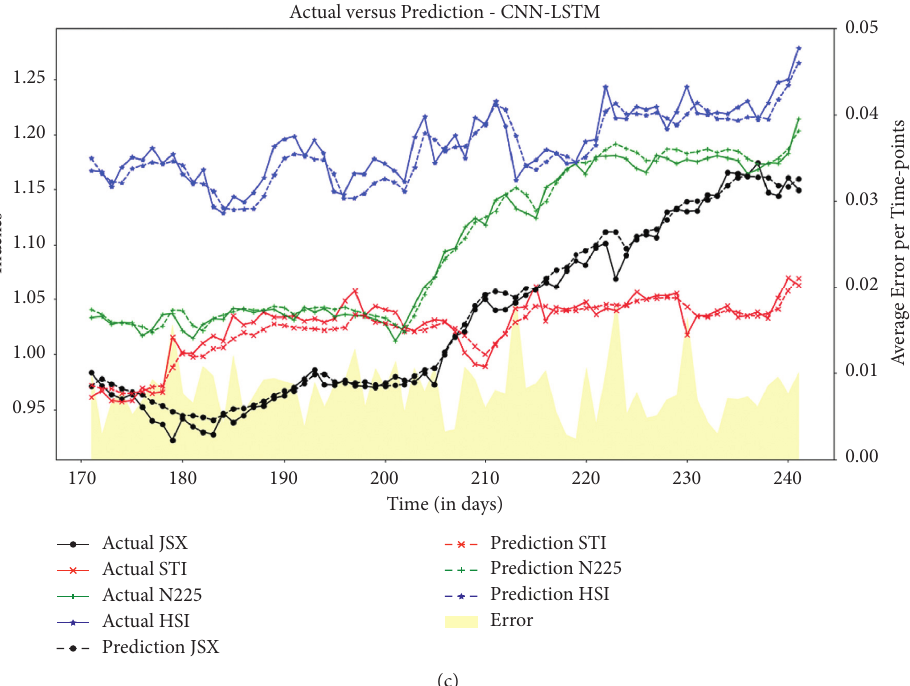
Figure 6: Comparison of the actual (solid line) and predicted values (dashed line) in the testing phase (last 72 trading days of the year 2020): (a) by CNN Model, (b) by LSTM model, and (c) by the ensemble of CNN-LSTM.